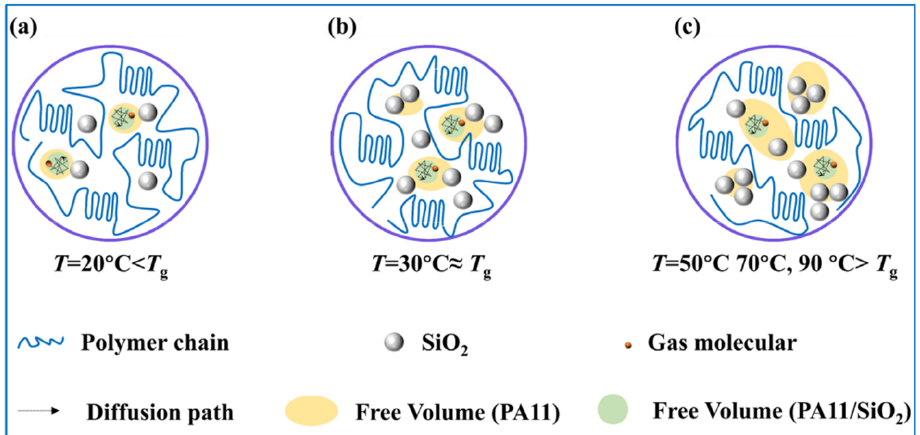
Figure 12. Diffusion paths of gas molecules and influence of nanoparticles on free volume at different temperatures, ( a ) PA11/0.5% SiO 2 , ( b ) PA11/1.0% SiO 2 , ( c ) PA11/1.5% SiO 2 .